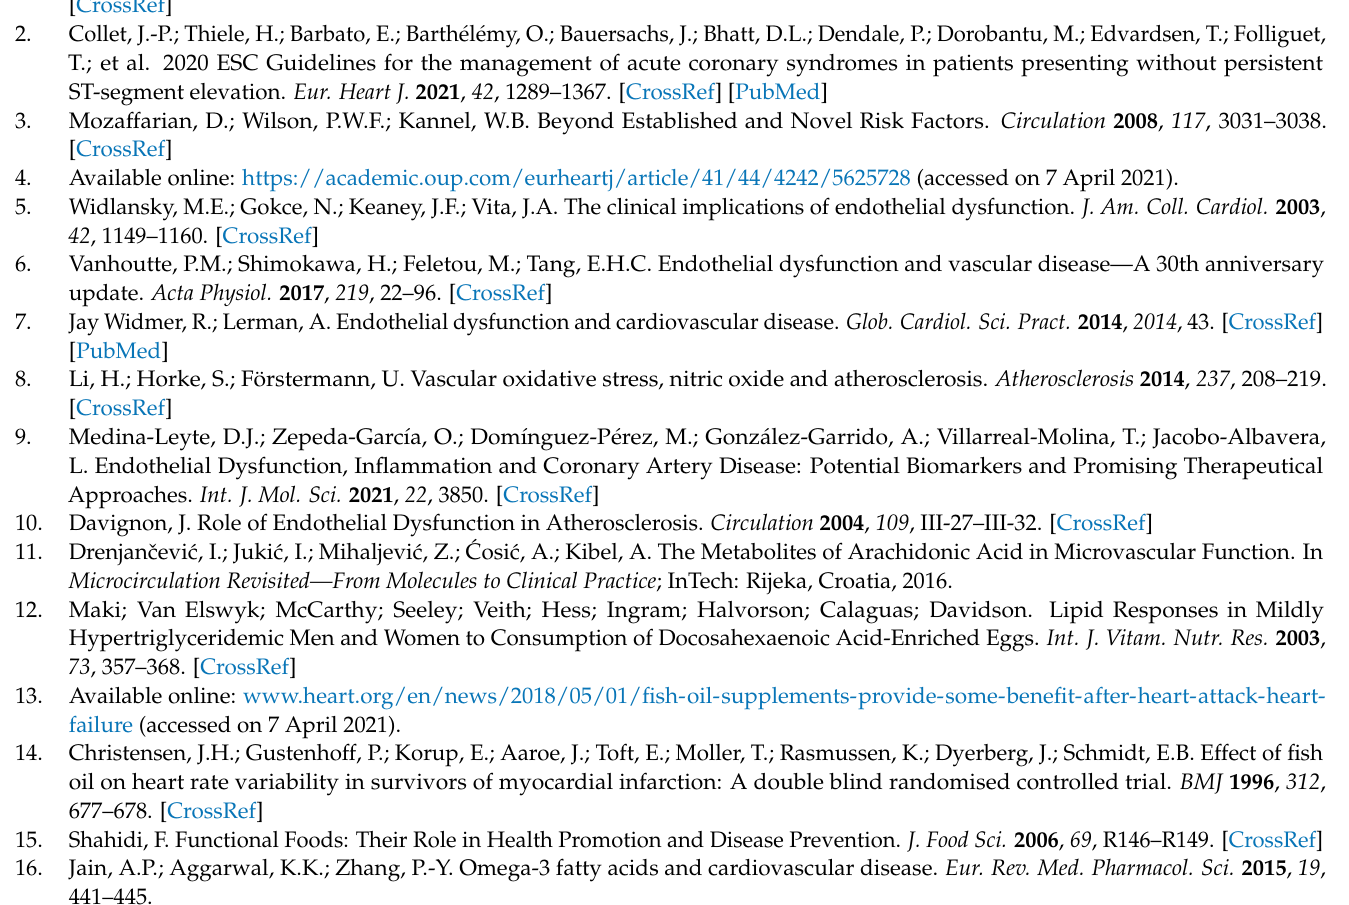
Table S1: Body composition and body fluid status responses to regular (control group) and n-3 PUFA-enriched hen egg (n-3 PUFAs group) consumption in the total study population (CAD) and in the two subgroups (Ac-CAD patients and Ch-CAD patients), Table S2: Body composition and body fluid status—measurement and